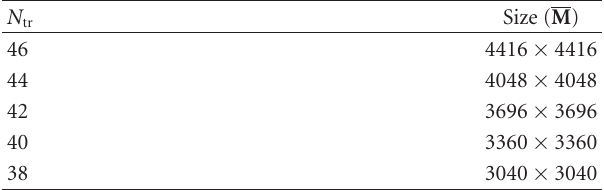
Table 2: Size of truncated M matrices.